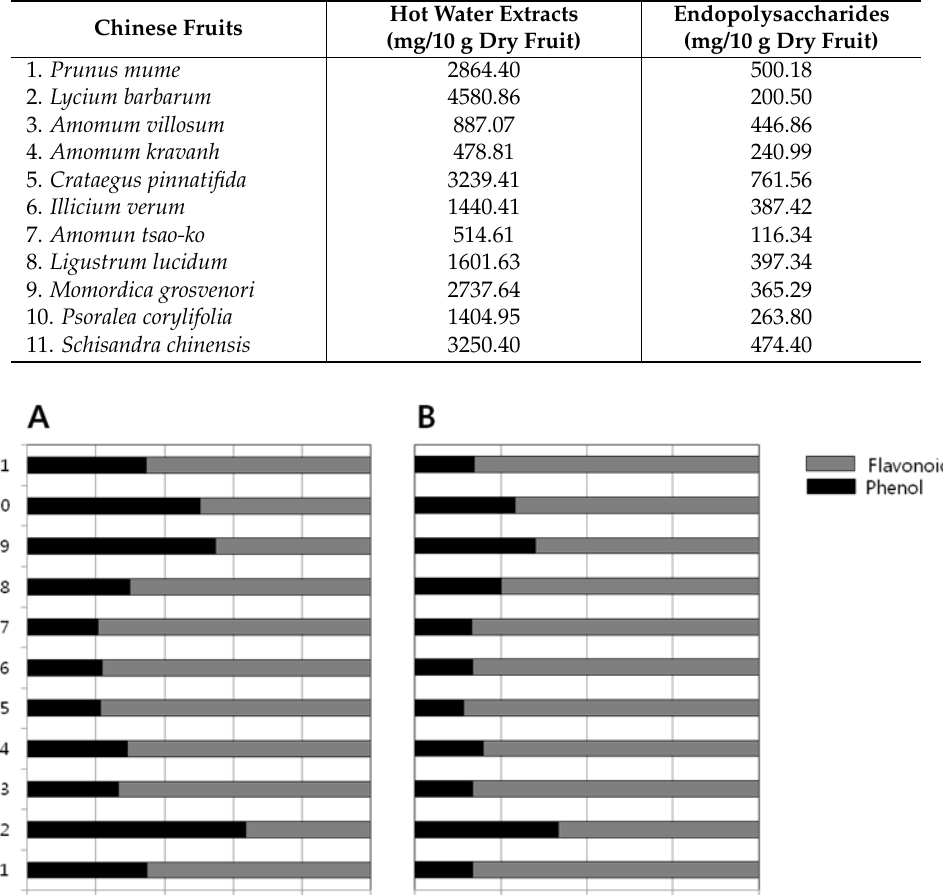
Table 2. Yields of hot water extracts and endopolysaccharides of fruits studied.